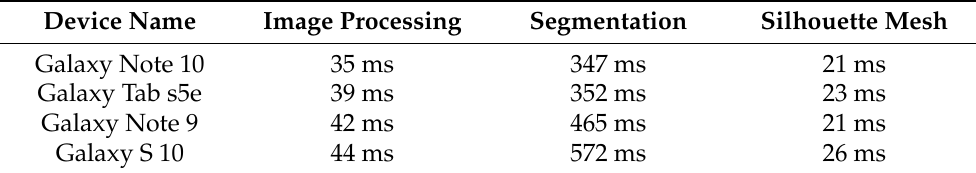
Table 2. Processing time comparison on different mobile device performed with median average on 100 trials.